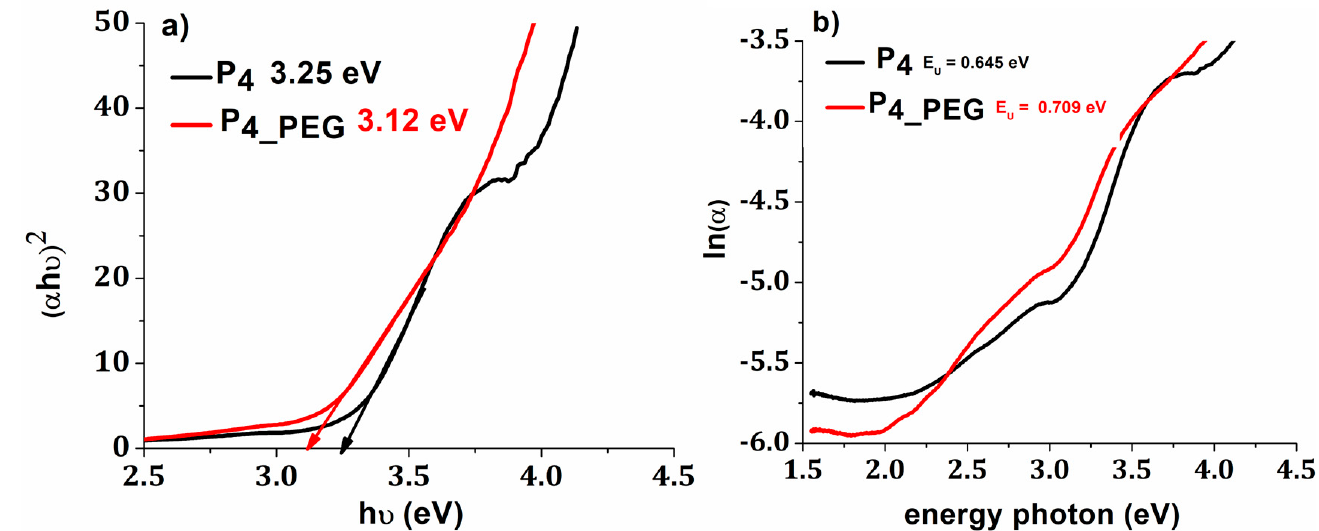
Figure 11. ( a ) plot of ( α h ν ) 2 versus h ν ; and ( b ) plot of ln( α ) versus photon energy. The structure diagrams for the obtained films based on the measured M–S flat band potential and band gap from the UV–VIS data are shown in Figure 12. Based on the measured CB and E g , the valence band (VB) energy of the films deposited on the FTO was